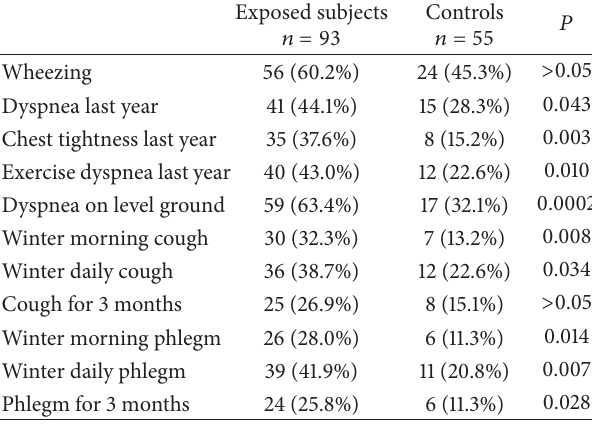
Table 2: Respiratory complaints of